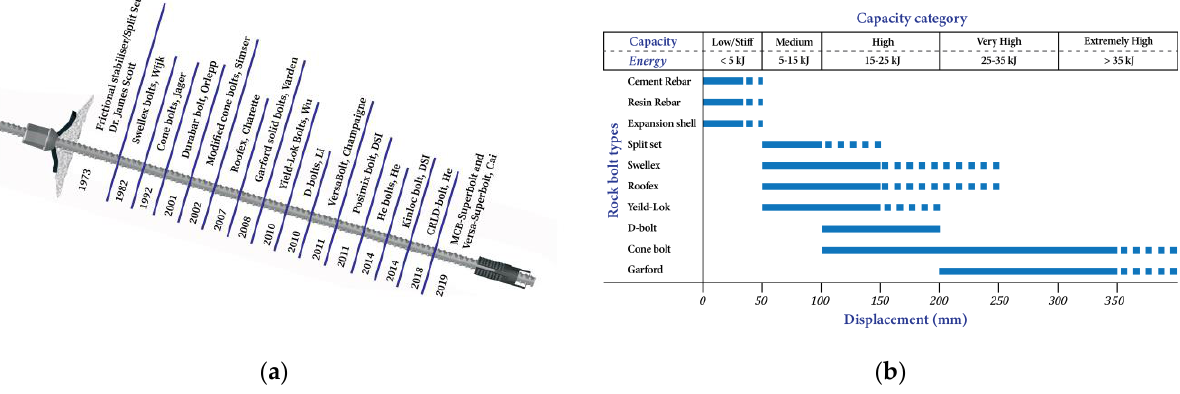
Figure 17. ( a ) Typical energy-absorbing bolts [184,208 – 215], ( b ). Energy dissipation capacity cate- gories of different types of reinforcement (Modified from [204]).